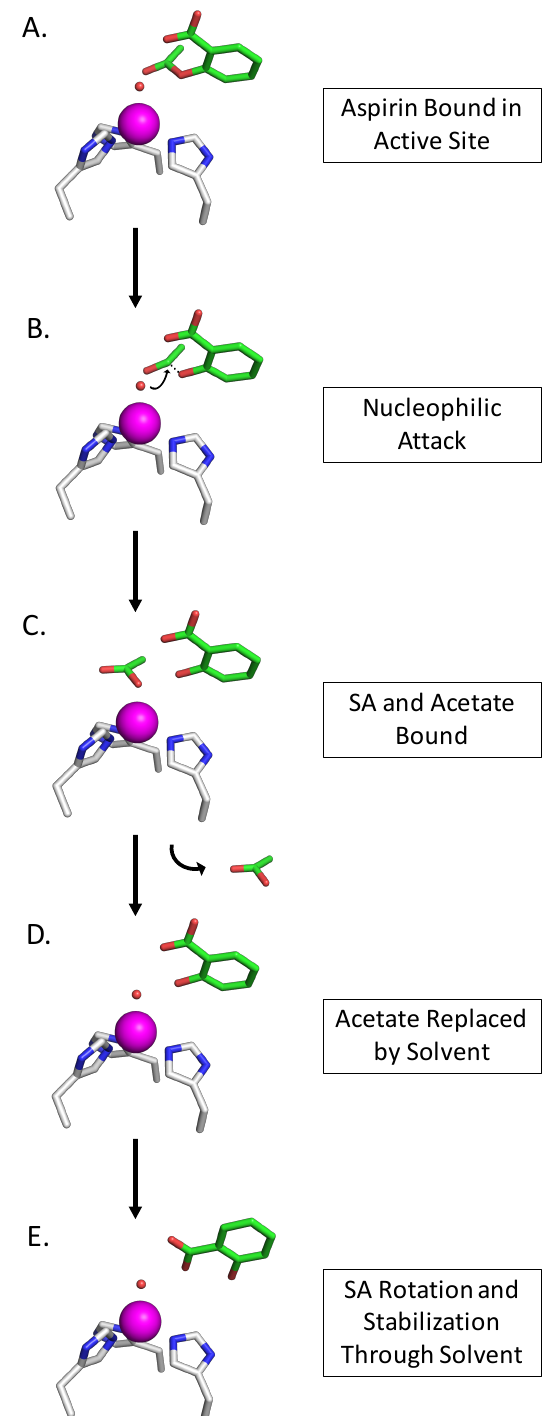
Figure 4. Proposed mechanism of CA esterase function, which converts Aspirin to SA. ( A ) Aspirin binds through the zinc bound hydroxyl orienting its acetyl group to how acetate binds in CAII (PDB: 1CAY). ( B ) The ester bond in Aspirin is cleaved via nucleophilic attack. ( C ) Once the ester bond is cleaved, acetate is generated and briefly is bound to the zinc. ( D ) A solvent molecule replaces acetate on the zinc and acetate is released to bulk solvent. ( E ) Salicylic acid rotates to bind its carboxylic acid moiety to the zinc bound solvent, stabilizing it within the active site.